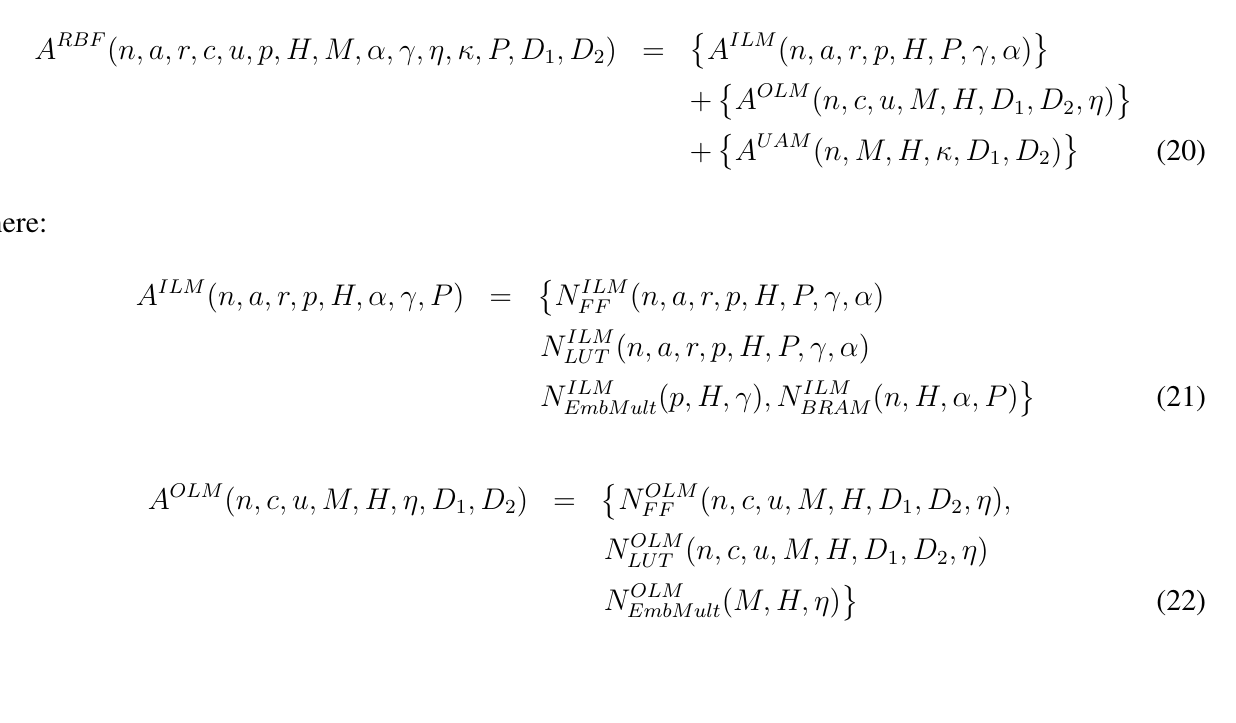
Figure 6. Updating of the synaptic weights, w